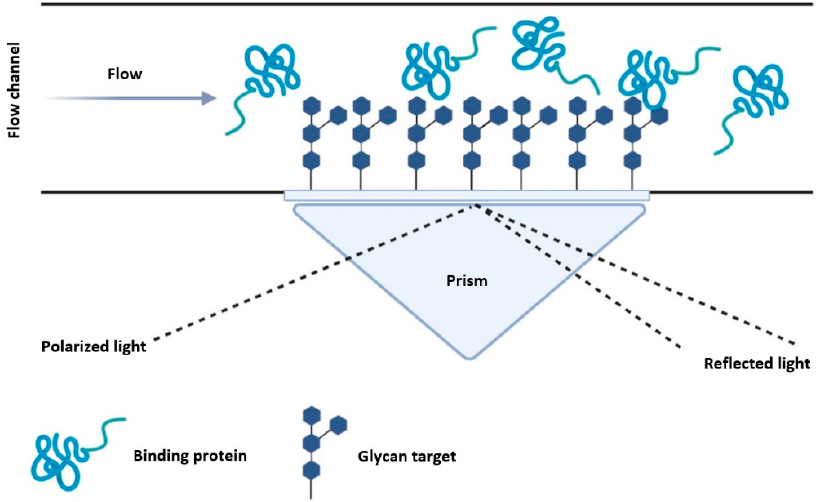
Figure 6. Overview of SPR with glycan labelled surfaces. Glycans are bound to a metallic surface inside a flow chamber and a GBP solution is introduced allowing the protein to bind. A light source excites the metallic surface, and the angle of the reflected light is relative to the mass at the surface, which enables binding kinetics to be determined.